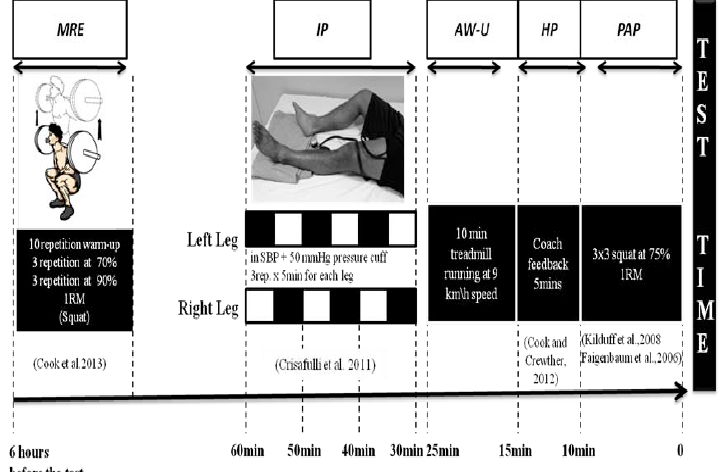
Fig.2 Preconditioning strategies for the PconSt protocol. 1RM = one repetition maximum, SBP = systolic blood pressure, MRE = morning resistance exercise, IP= ischemic preconditioning, AW-U= active warm-up, HP = hormonal preconditioning and PAP = post-activation potentiation. Within the IP section, black boxes represent 5 minutes of metatarsal arterial occlusion and white boxes represent 5 minutes of